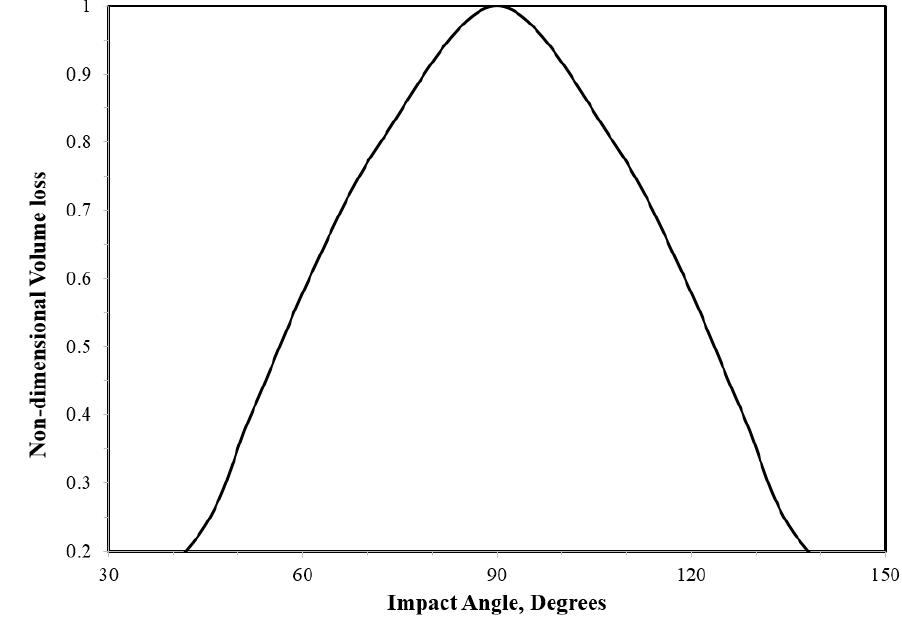
Figure 12. Non-dimensional volume loss of stainless steel as function of impact angle [33].